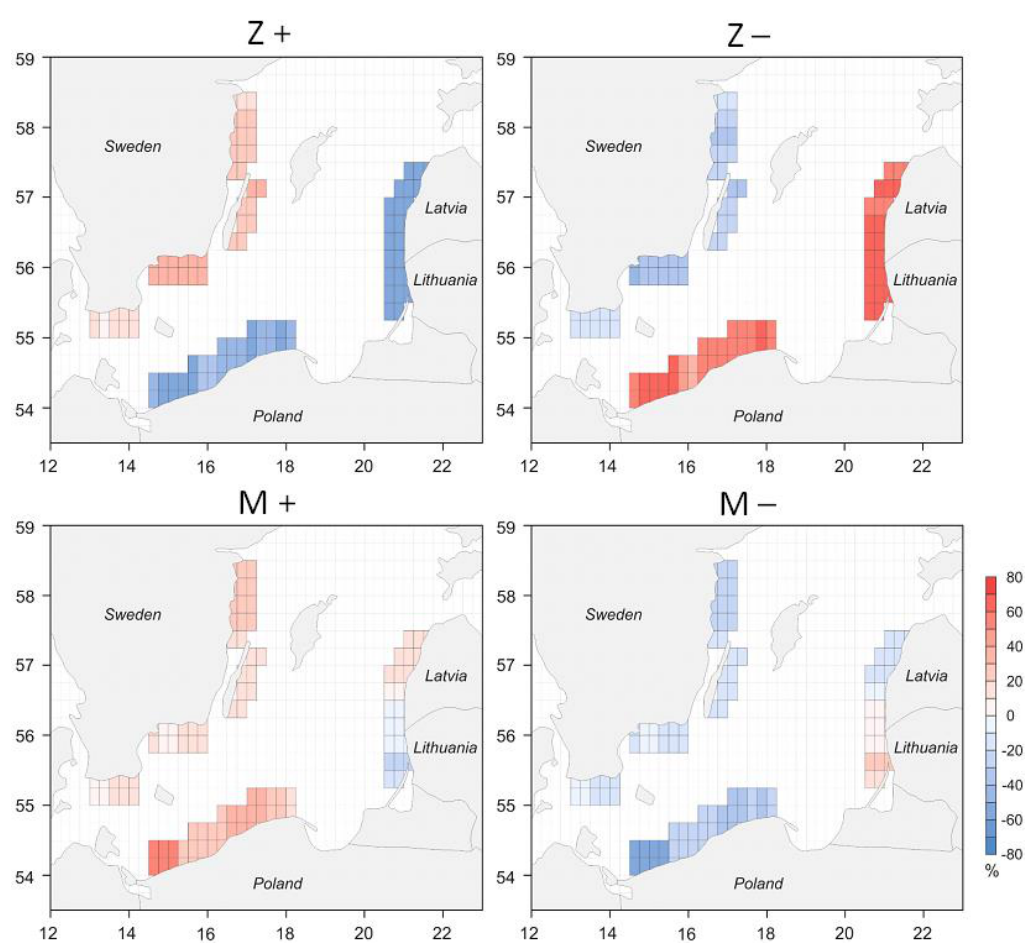
Figure 7. Anomalies of upwelling frequency in positive ( + ) and negative ( − ) phases of zonal (Z) and meridional (M) circulation.